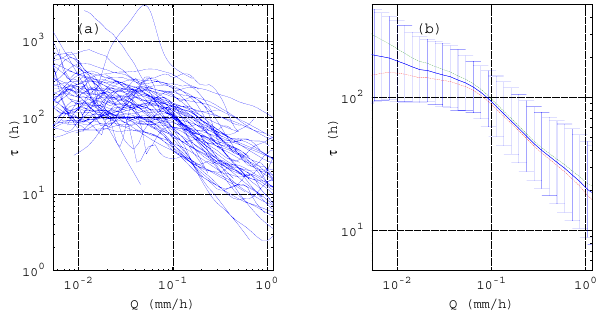
Fig. 5. (a) Fitted recession time τ vs. Q across the 61 streams. (b) Inverse-variance weighted mean recession timescale τ (solid curve, with range from weighted within-site uncertainty shown by upper and lower dashed curves) along with variability across streams (weighted standard deviation shown by error bars). Vari- ability in recession curves across streams is consistently much greater than the uncertainty associated with recession-curve estima- tion for individual streams, meaning that most of the variability in recession times seen across streams is real.